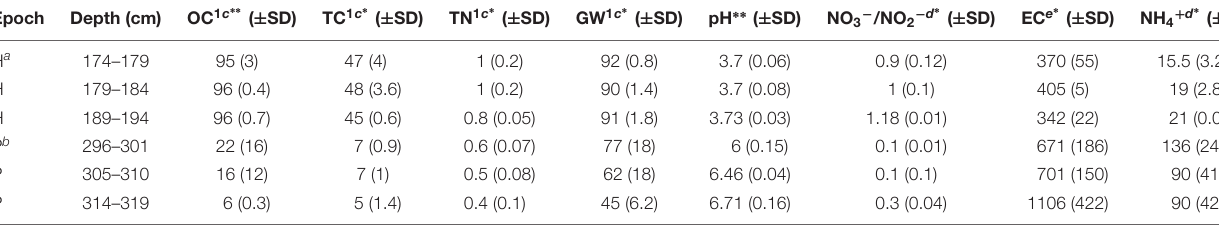
TABLE 1 | Basic soil edaphic parameters of the selected segments for microbial analysis.